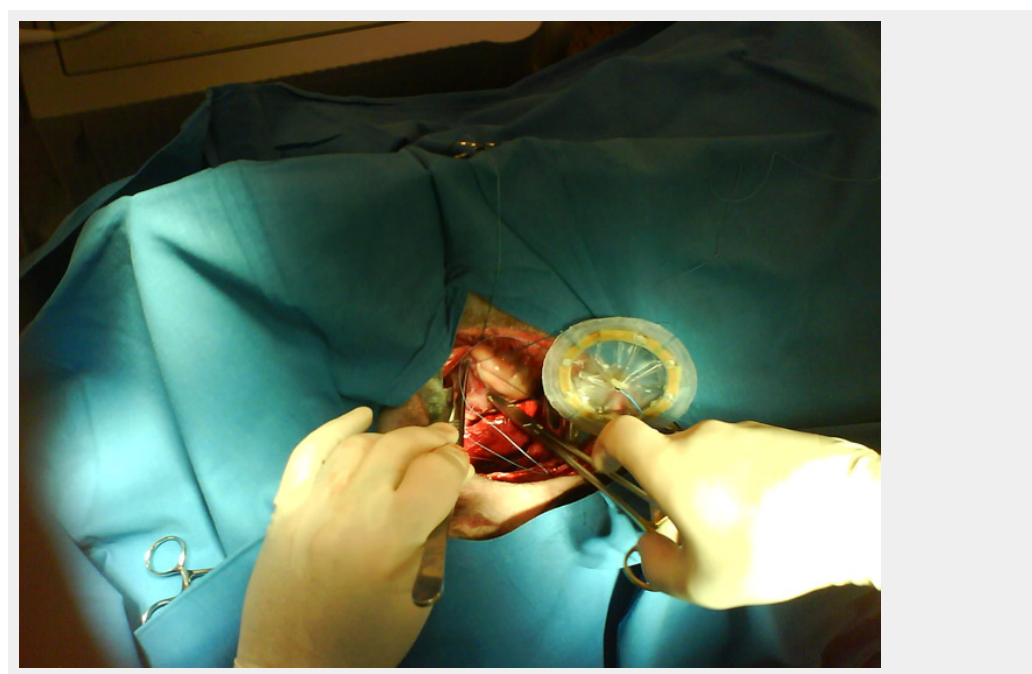
Animal implant of the Atripump. The concave part is assumed to touch atrium’s epicardium. When ON, the dome reduces its depth pushing down the atrial wall. When OFF, the dome returns to its rest position allowing atrial